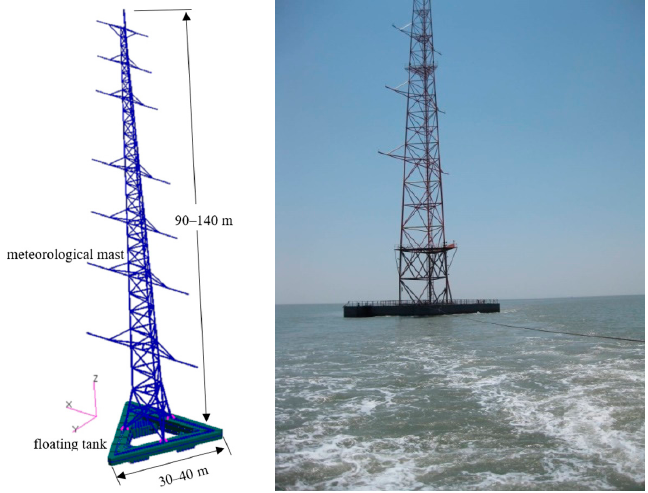
Figure 1. Offshore integrated meteorological mast and towing operation. Figure 1. O ff shore integrated meteorological mast and towing